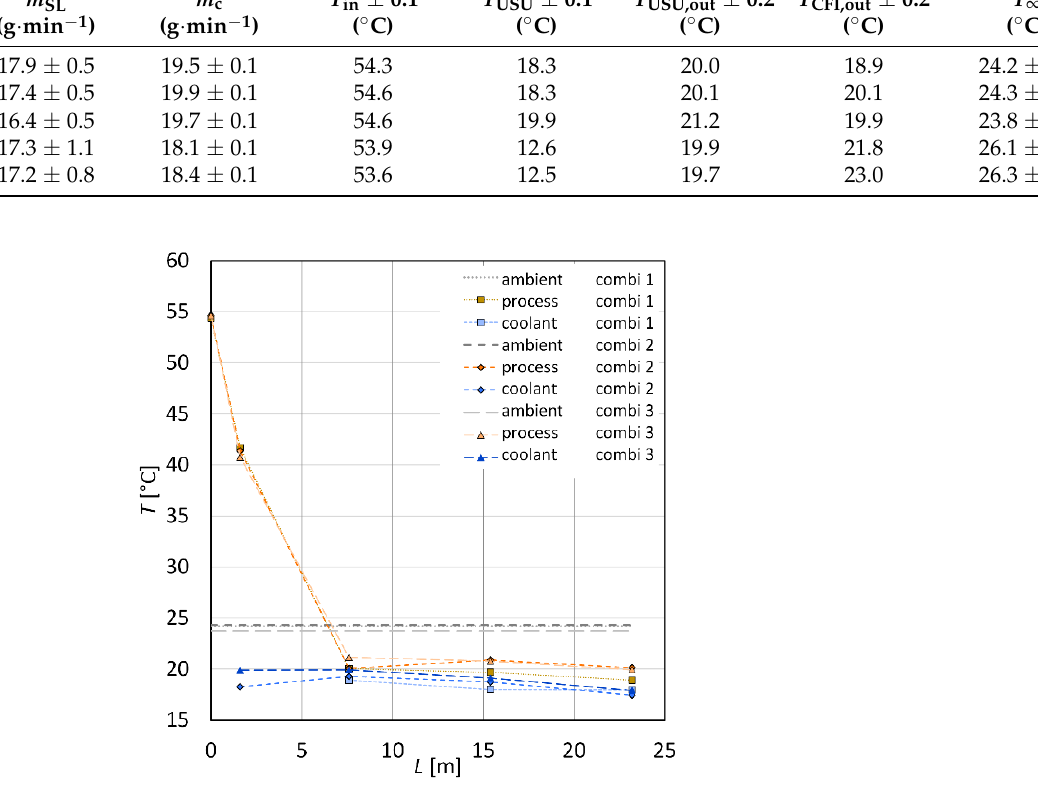
Table A7. Process parameters for combined nucleation and crystal growth experiments. Sample